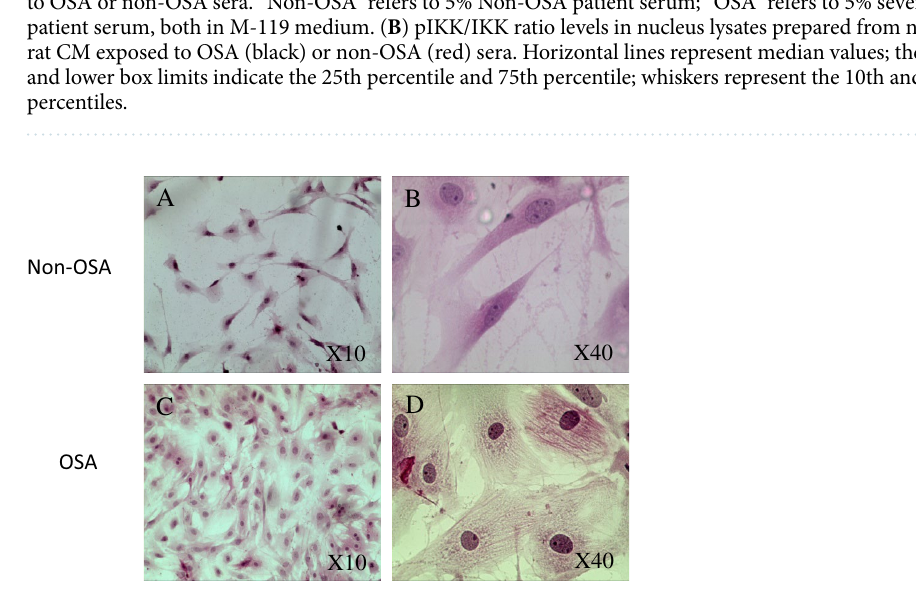
Figure 5. H&E staining of immortalized human CM treated for 48 h with non-OSA serum: [( A ) ×100, ( B ) ×400]; or with OSA serum [( C ) ×100, ( D )